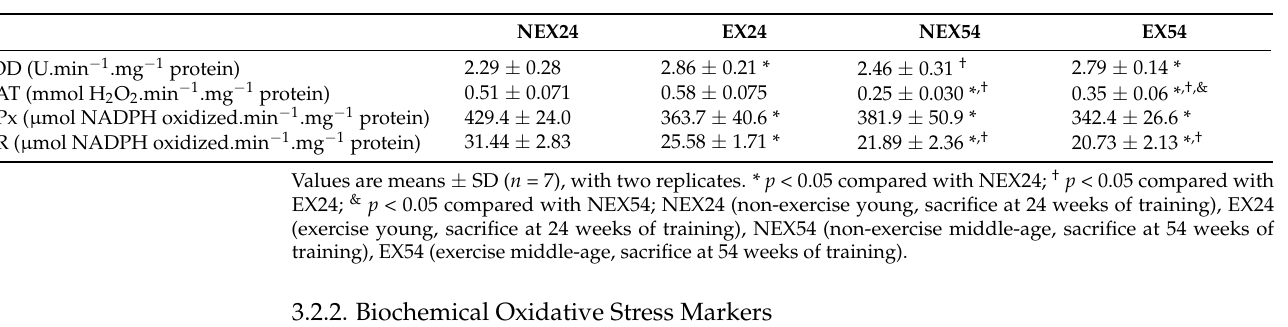
Table 3. Activity of hepatic antioxidant enzymes. Superoxide dismutase (SOD), Catalase (CAT), Glutathione peroxidase (GPx), Glutathione reductase (GR).